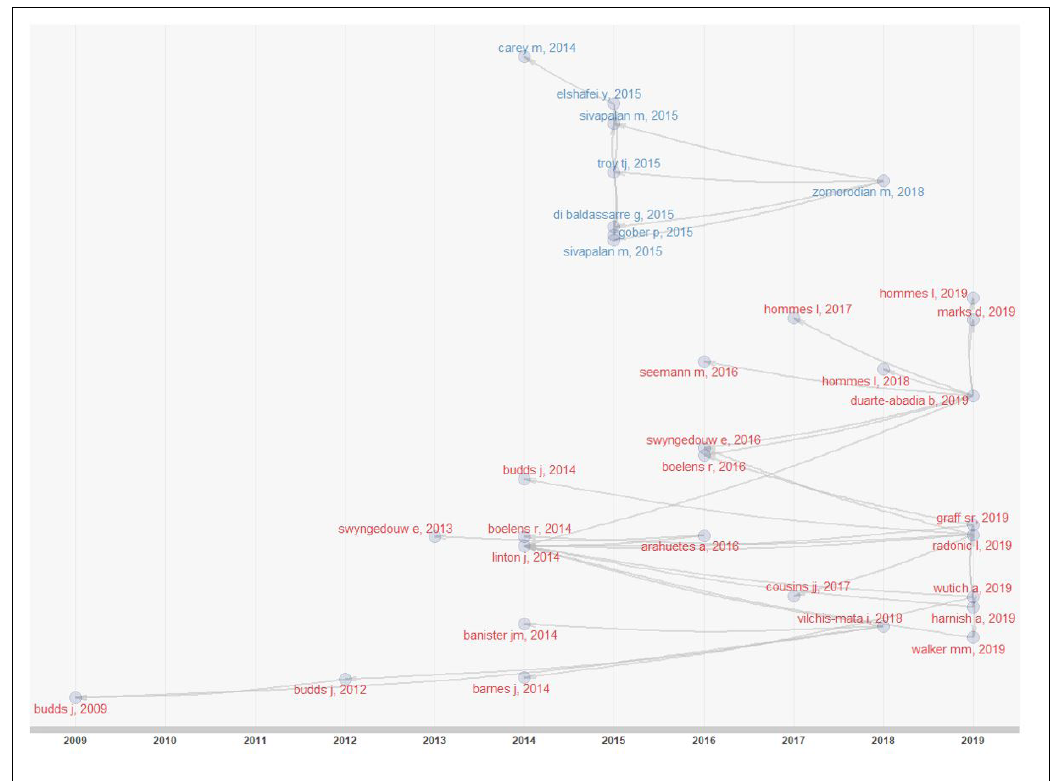
Figure 6: Historical direct citation network of hydrosocial